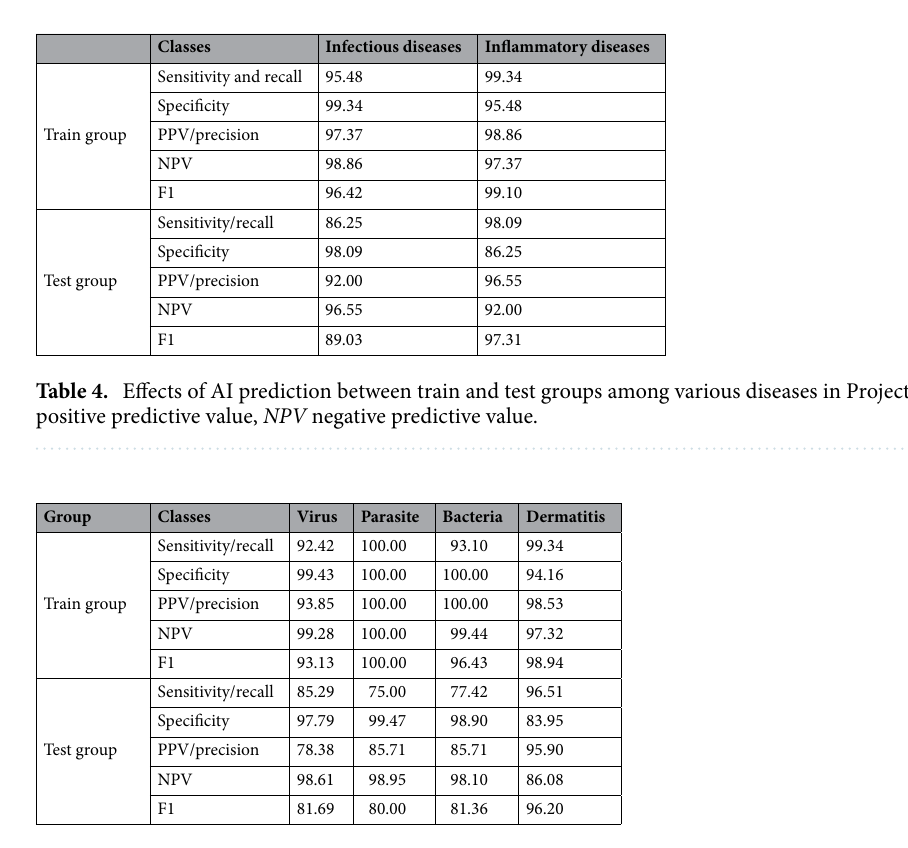
Table 5. Effects of AI prediction between train and test groups among various diseases in Project 3(%). PPV positive predictive value, NPV negative predictive